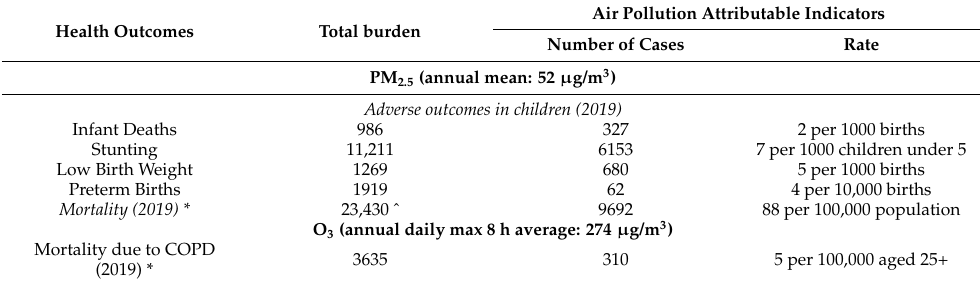
Table 5. Long-term impacts of air pollution on mortality and adverse outcomes in children.